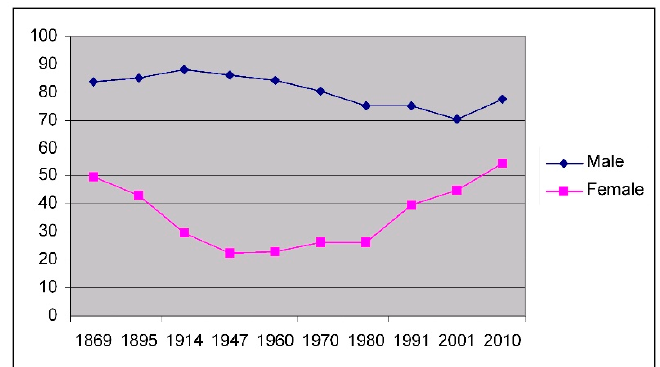
Figure 2. Changes of participation rates of male and female work taking into account INDEX Censuses dates. [27], p.4.